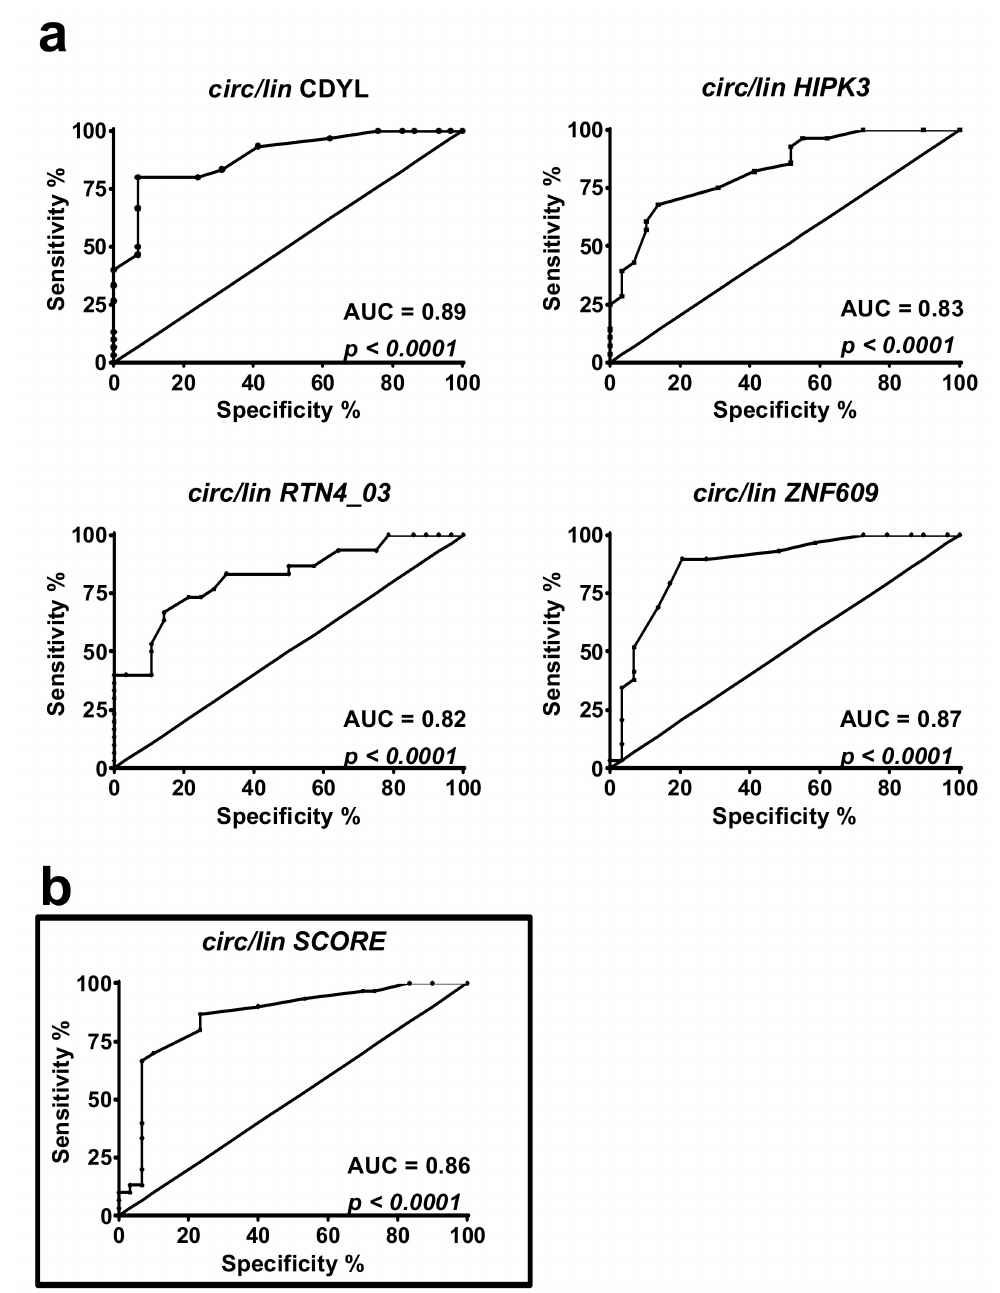
Figure 2. Discrimination of DM1 patients from controls using circular-to-linear ratios of DM1-circRNAs. ( a ) Receiver operating characteristic (ROC) curves show the sensitivity and specificity of each circRNA fraction (circ / lin) and of the combined “circular-to-linear score” to distinguish DM1 from healthy biceps brachii muscle tissue. ( b ) The “circular-to-linear score” was calculated by averaging the significantly modulated circular-to-linear ratios (circ / lin score, black rectangle). DM1 = 30, CTRL =